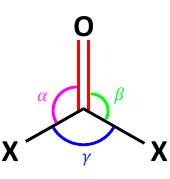
Figure 1. The three angles α , β and γ for a molecule with topology X 2 CO. A balanced choice of bond angles for the non-redundant parameter set consists of (i) angle γ and (ii) angle δ , which is an antisymmetric combination of angles α and β (i.e., δ = α − β